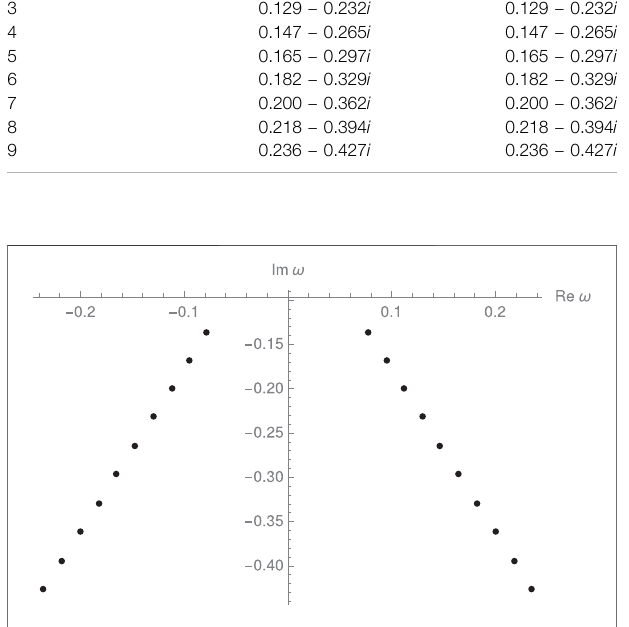
FIGURE 1 | First ten QNFs of the Klein-Gordon fi eld with mass m (cid:1) 1/10 propagating in the 2D black hole (2) of radius r + (cid:1) 70.